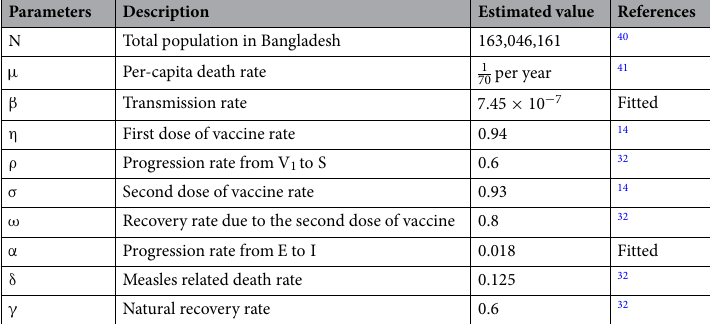
Table 1. Depiction and estimation of the measles model (2)–(7)